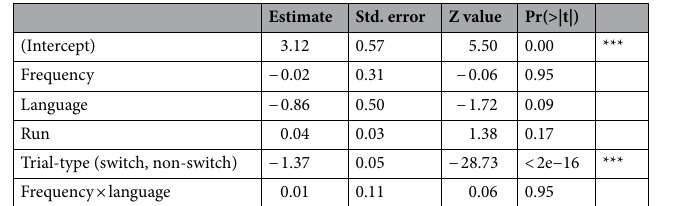
Frequency × Table 4. Results from generalized linear mixed effect models predicting accuracy for color data.